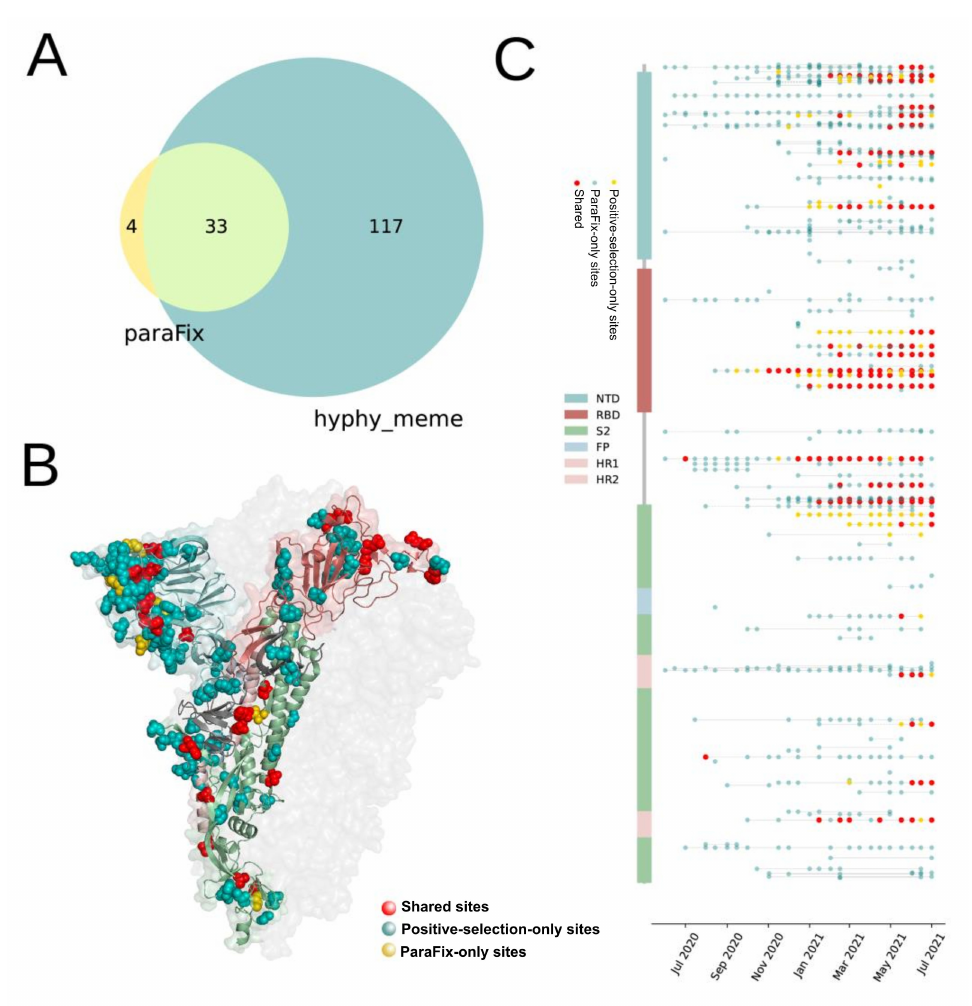
Figure 3. Distribution of sites with parafix mutations and positive selection sites in SARS-CoV-2 S protein ( A ) The number of detected sites with paraFix mutations and positive selection sites. ( B ) The distribution of sites with paraFix mutations and positive selection sites on the structure of S protein (PDB ID: 7df3). ( C ) Time-dependent observation of detected sites with paraFix mutations (Yellow), positive selection sites (blue) and the shared sites in S protein across 27 timepoints, from June 2020 to July